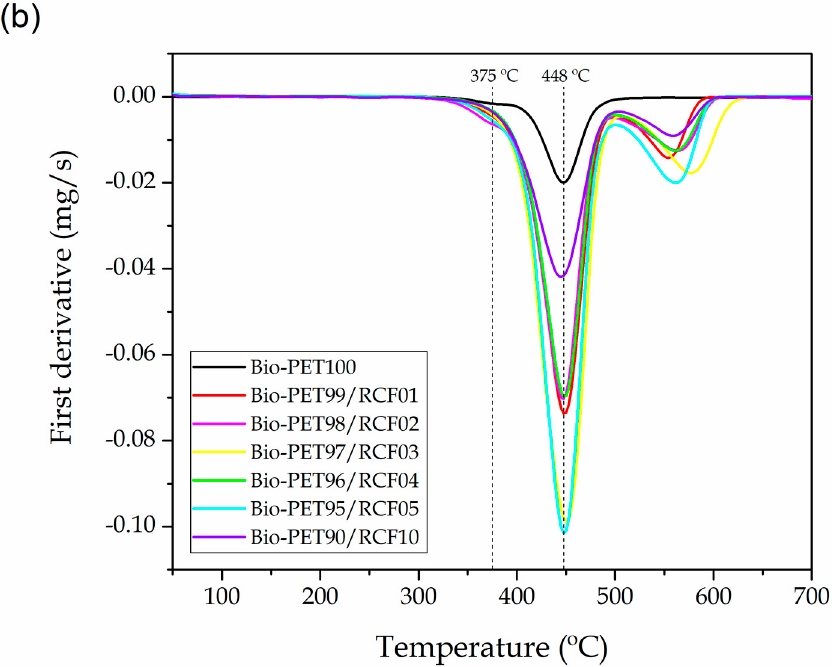
Figure 4. ( a ) Thermogravimetric analysis (TGA) and ( b ) first derivative thermogravimetric (DTG) curves of the bio-based polyethylene terephthalate (bio-PET)/recycled cotton fiber (RCF) composite